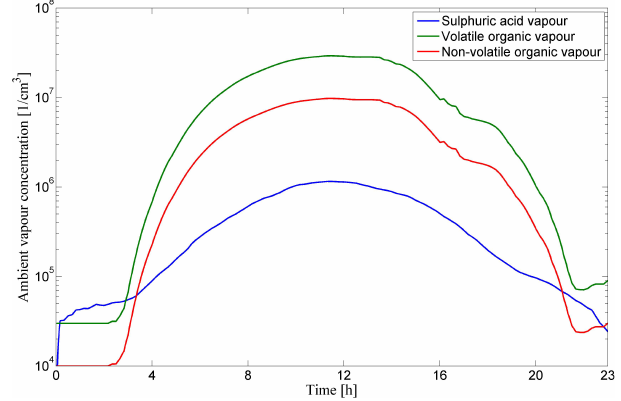
Fig. 1. The ambient vapour concentrations for sulphuric acid (blue), non-volatile organic compound (red) and volatile organic compound (green) as applied in the EKF implementation for 7 May